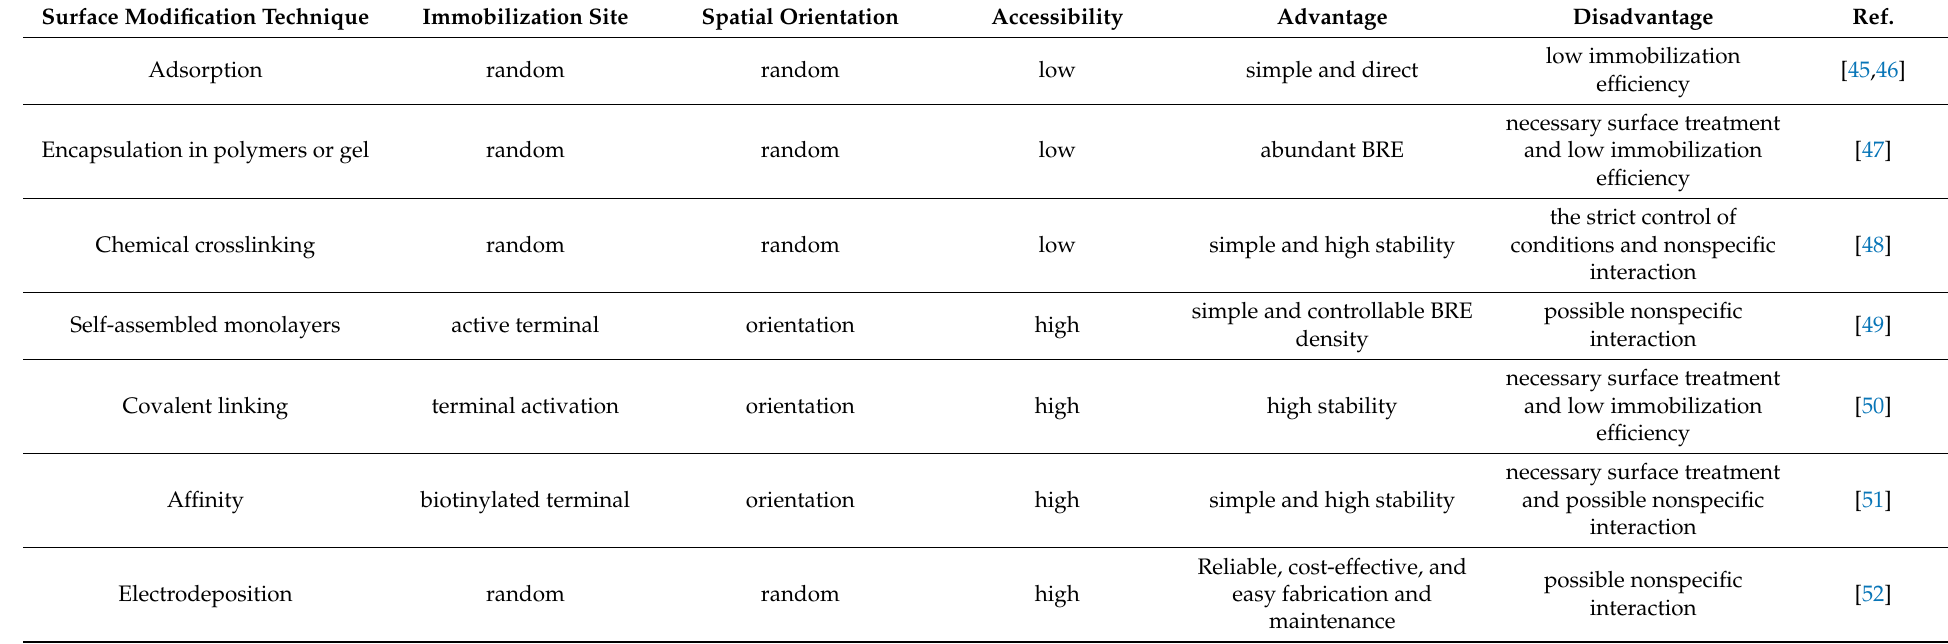
Table 1. Surface modification techniques of BRE in electrochemical